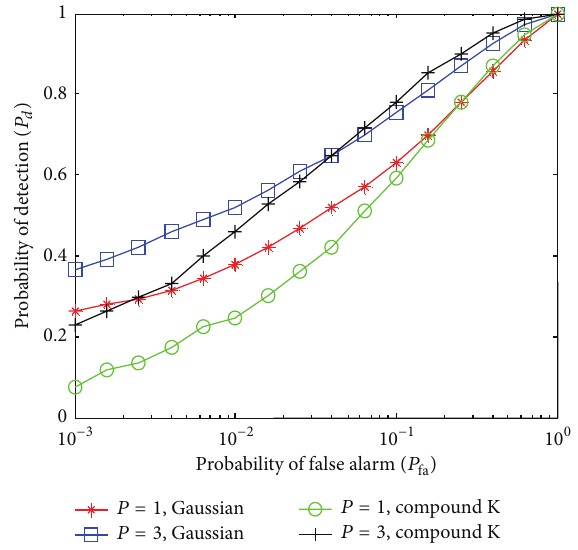
Figure10:Effectofthemultipathnumberondetectionperformance in Gaussian and compound K-distribution clutter.